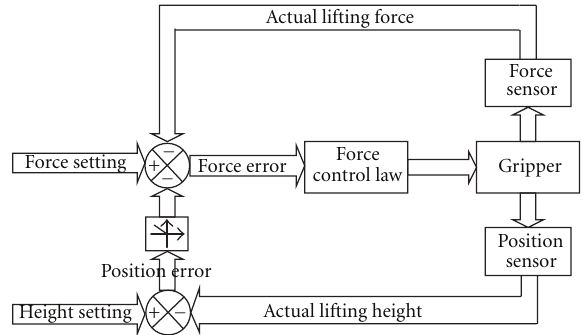
Figure 4: Construct of the hybrid control system.